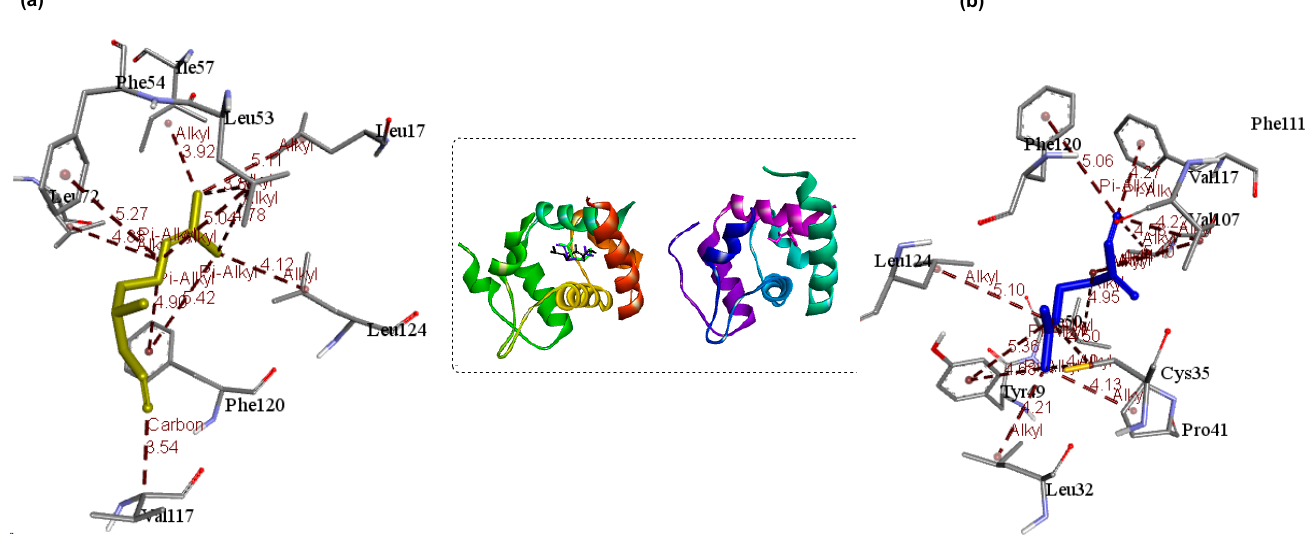
Figure 11. 3D interactions showing the selected ligands: ( a ) citronellal, and ( b ) myrcene with the most interaction at the active sites of the OBP 7.